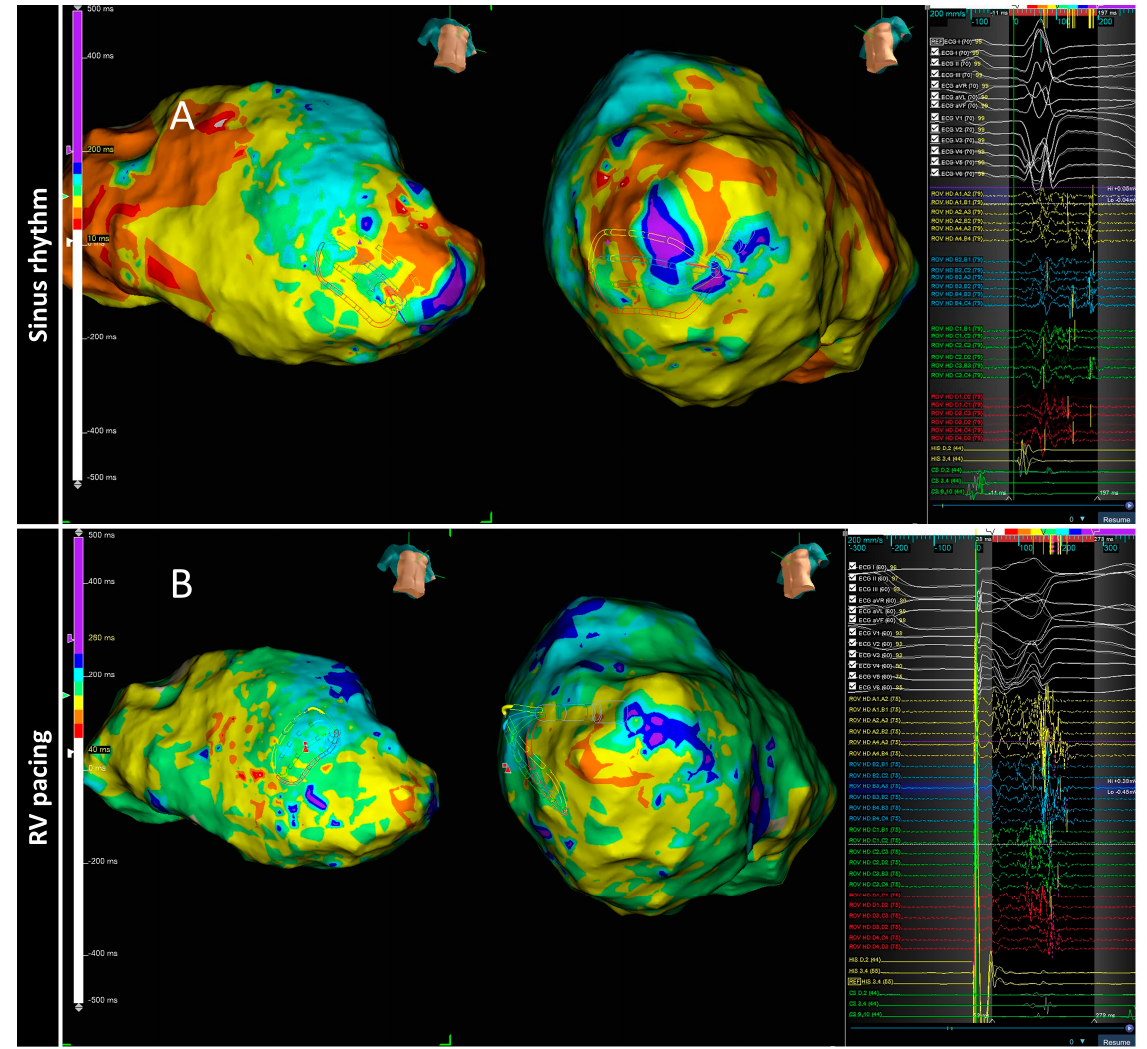
Figure 4. The spatial distribution of activation slowing is influenced by the direction of left ventricular activation. An example of two different maps performed in the same patient during two different ventricular activations: spontaneous sinus rhythm ( A ) and RV pacing ( B ). The general zone of activation slowing was similar between maps, similar to the signals shown on the right side of the panels obtained at each HD grid catheter location depicted, consequently, this area should be ablated according to the PHISIO-VT study